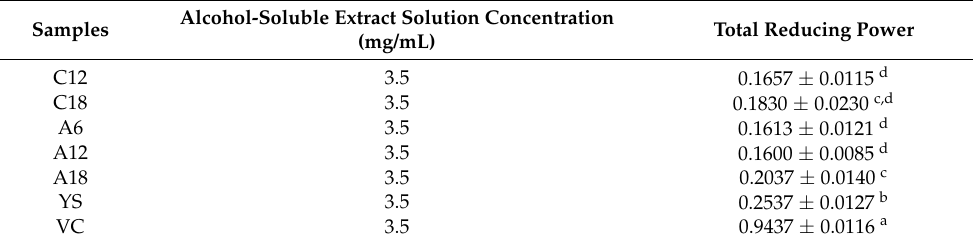
Table 4. The total reducing powers of all five batches and controls.